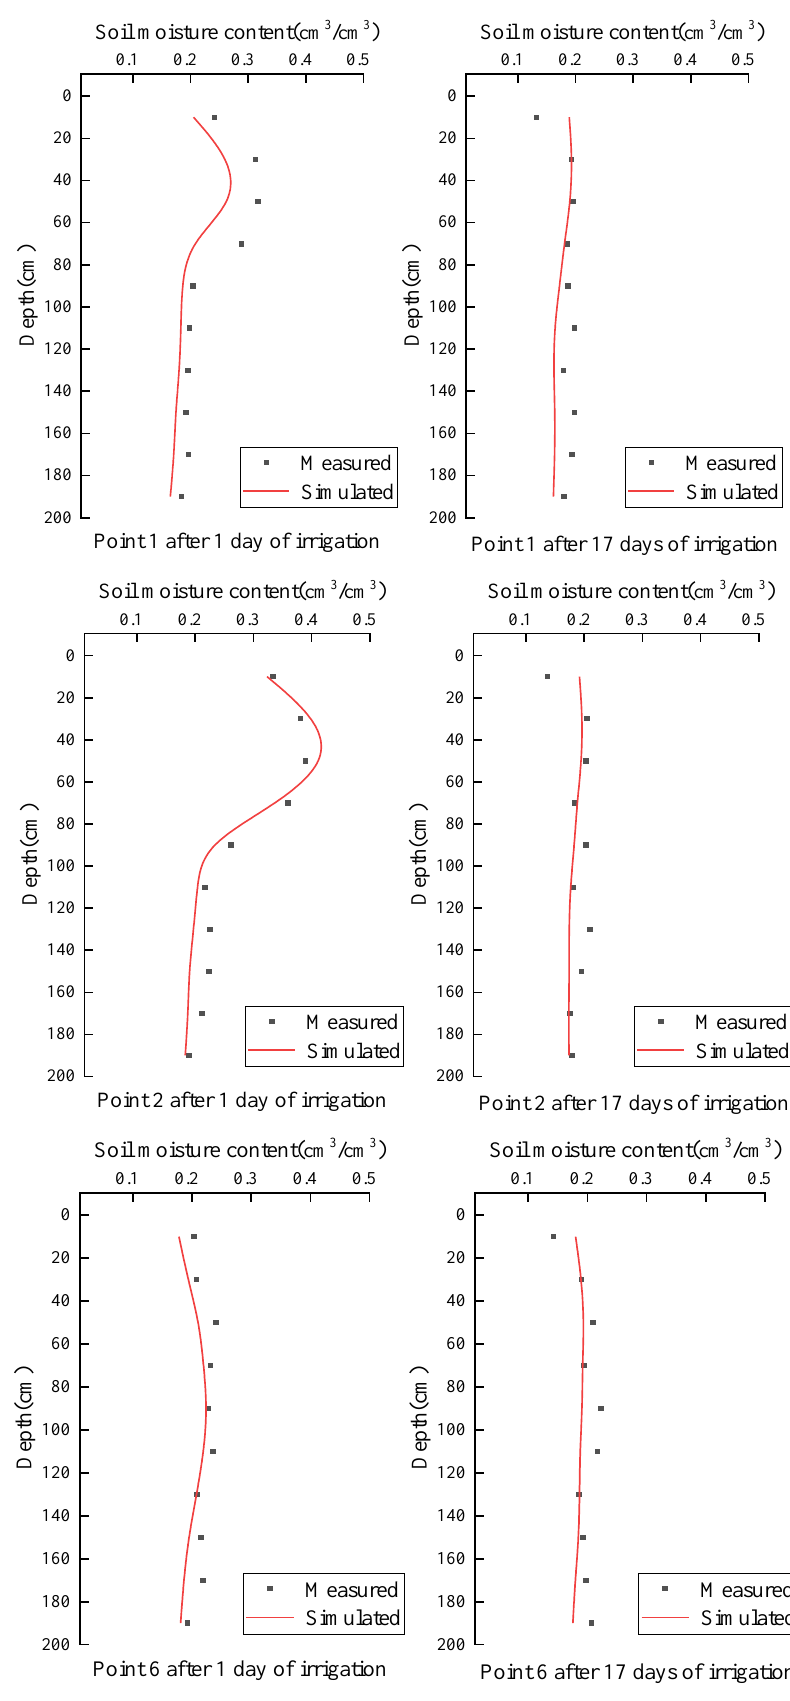
Figure 7. Measured and simulated values of soil moisture content at different times and profiles.